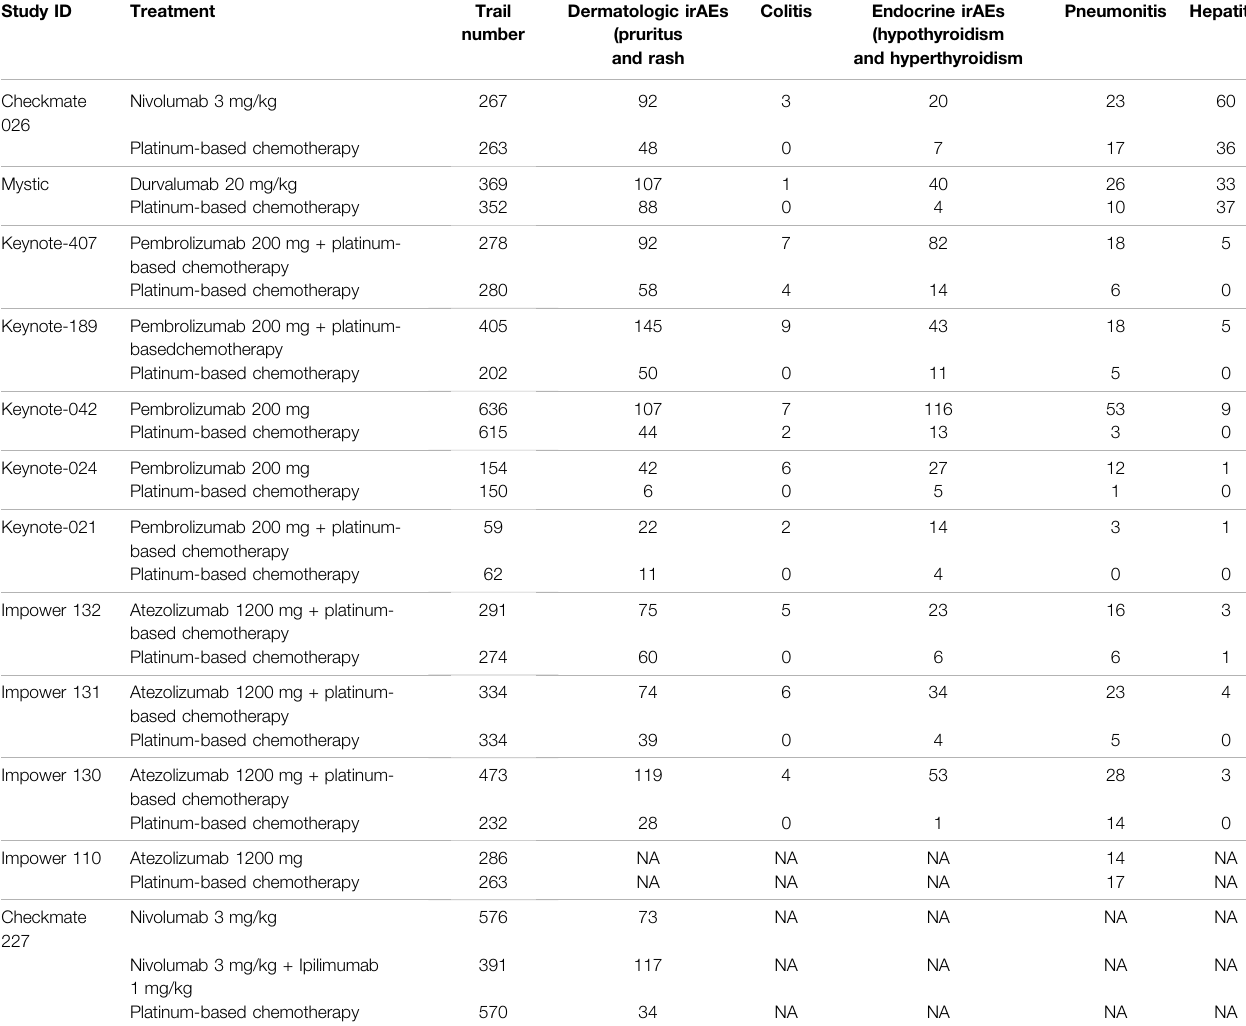
TABLE 2 | Patient characteristics and extracted data for study end-points in the included randomised controlled trials. Study